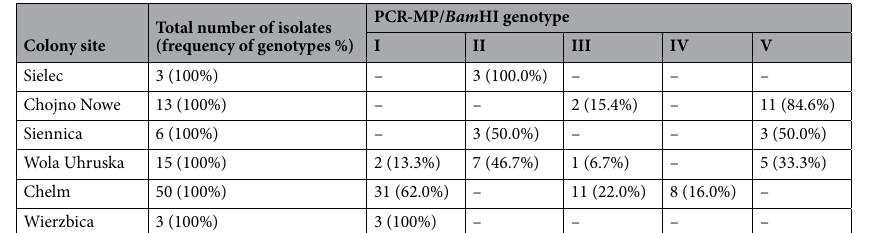
Table 1. PCR-MP/ Bam HI genotypes of A. keratinophilus strains isolated from rook pellets and frequency of obtained genotypes.